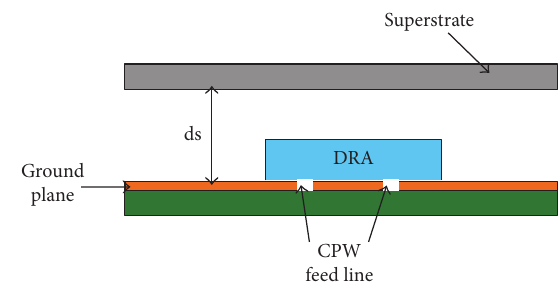
Table 8: Comparison between the volume of DRAs excited at 24 GHz by TE 111 , TE 115 , and TE 119 modes. Resonant mode